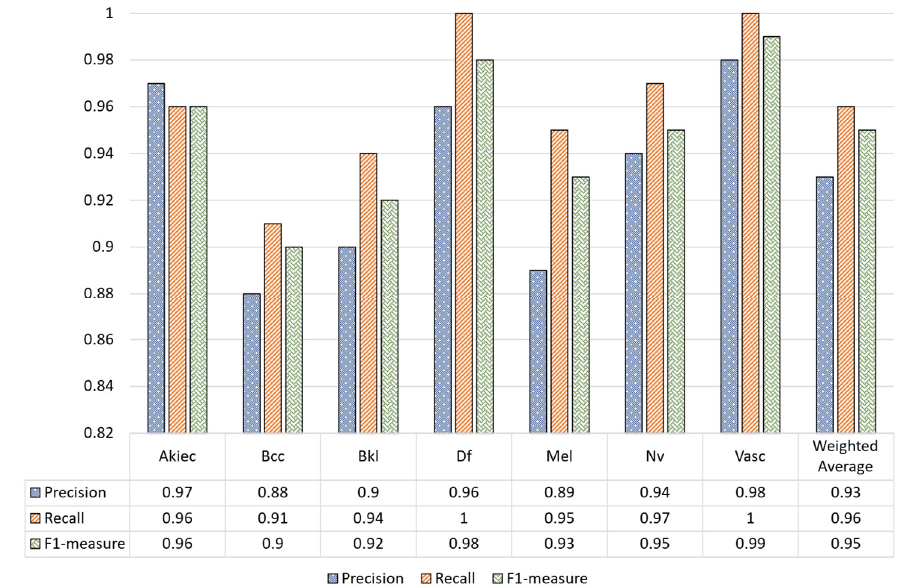
Figure 7. Classification report of our model using the preprocessing stage.